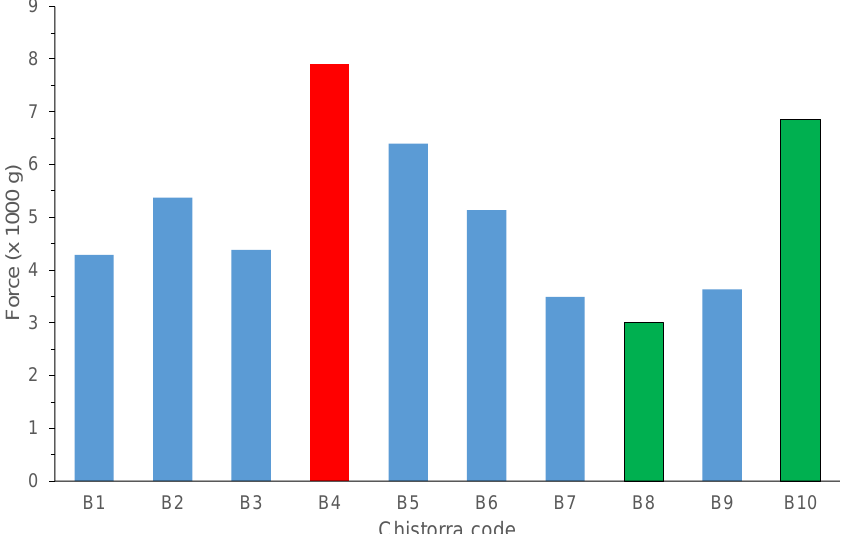
Figure 3. Warner Bratzler Shear Force texture results for the chistorras scored at step 3. Red bar refers to the winner chistorra ; green bars, refer to the finalist ones.